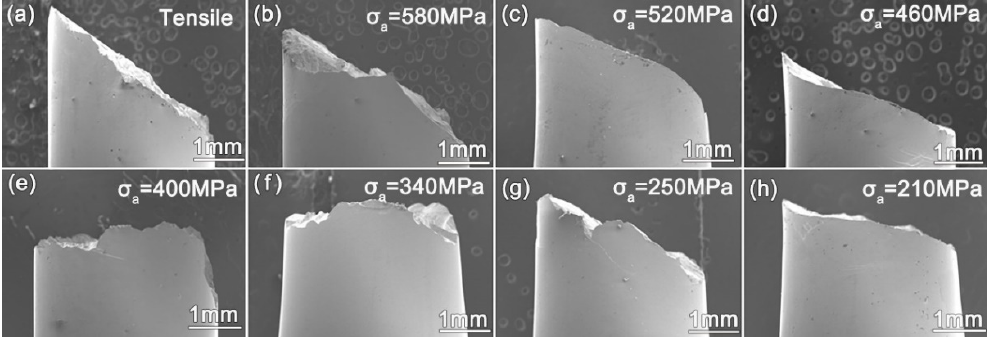
Figure 2. ( a ) Fractured Zr 61 Ti 2 Cu 25 Al 12 glass specimen in uniaxial tension. ( b – h ) Side morphology of Zr 61 Ti 2 Cu 25 Al 12 specimens fatigue fractured at tensile stress amplitudes of 580, 520, 460, 400, 340, 250, and 210 MPa, respectively.